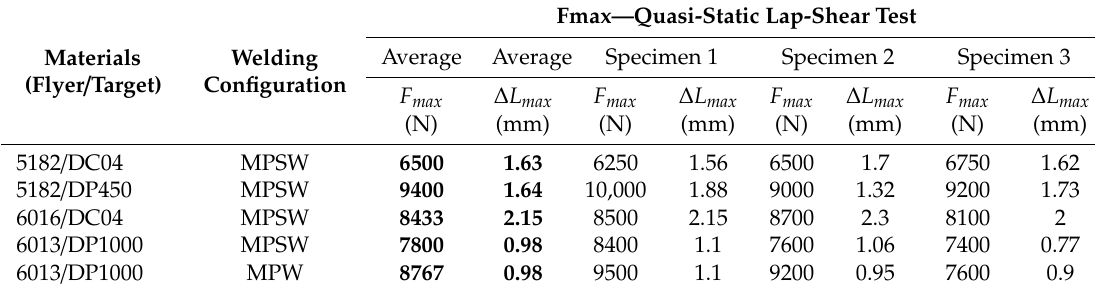
Table 11. Quasi-static lap-shear tests